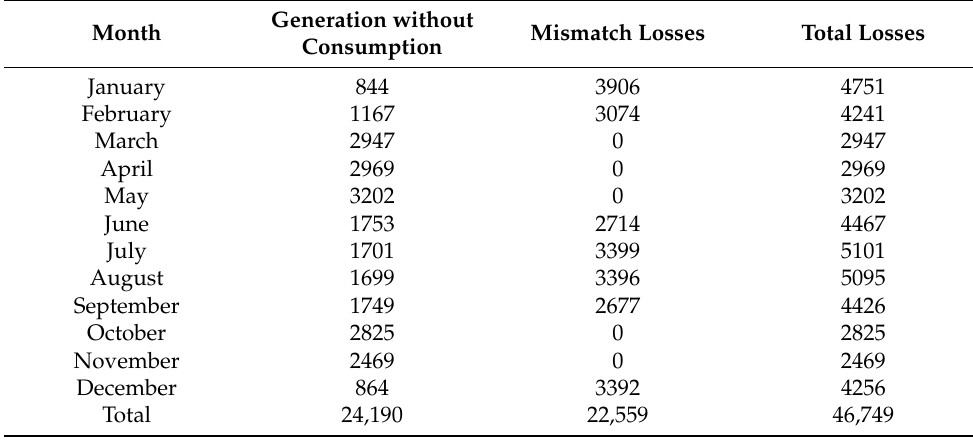
Table 6. 17.76 kWp solar pump PVsystem loss analysis.